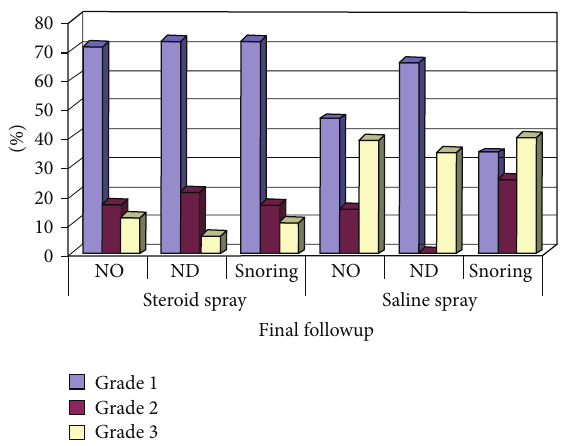
Figure 1: Description of nasal symptoms grades among steroid and saline patients at the last followup, 1 year postoperatively. This graph shows the differences between the nasal symptoms grades between both study groups after 1 year (NO: nasal obstruction, ND: nasal discharge, Grade 1 = mild, Grade 2 = moderate, and Grade 3 = severe).